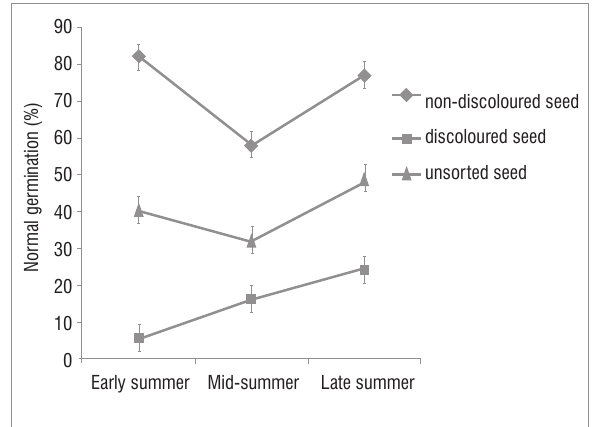
Figure 2: Effect of planting date and seed category on normal germination.